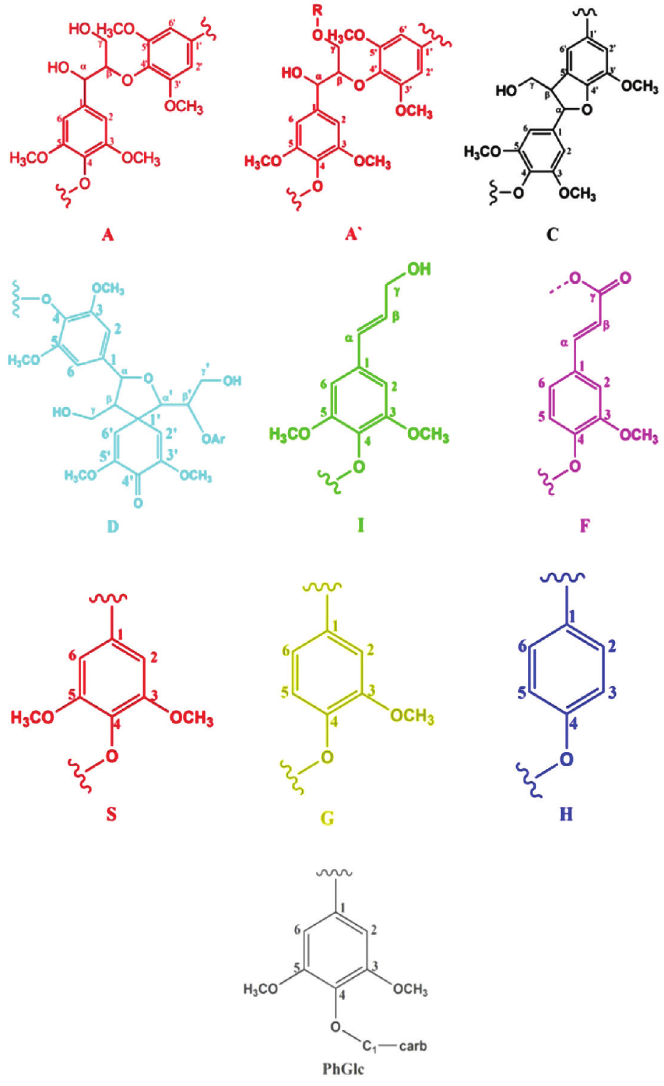
Fig. 2 – Main classical side-chain linkages and aromatic subunits of l-SSA from corncob detected by 2D HSQc NMR spectrum: (A) β-o-4’ aryl ether linkages with a free –oH at the γ-carbon; (A’) β-o-4’ aryl ether linkages with acetylated –oH at the γ-carbon; (c) phenylcoumarane substructures formed by β-5’ and α-o-4’ linkages; (D) spirodienone substructures formed by β-1’ and α-o-α’ linkages; (I) p-hydeoxycinnamyl alcohol end groups; (F) ferulates; (S) syringyl units; (G) guaiacyl units; (H) p-hydroxyphenyl units; (PhGlc) phenyl gly -